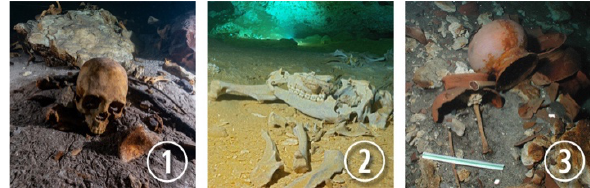
(1) Human and (2) animal remains, (3) artifacts